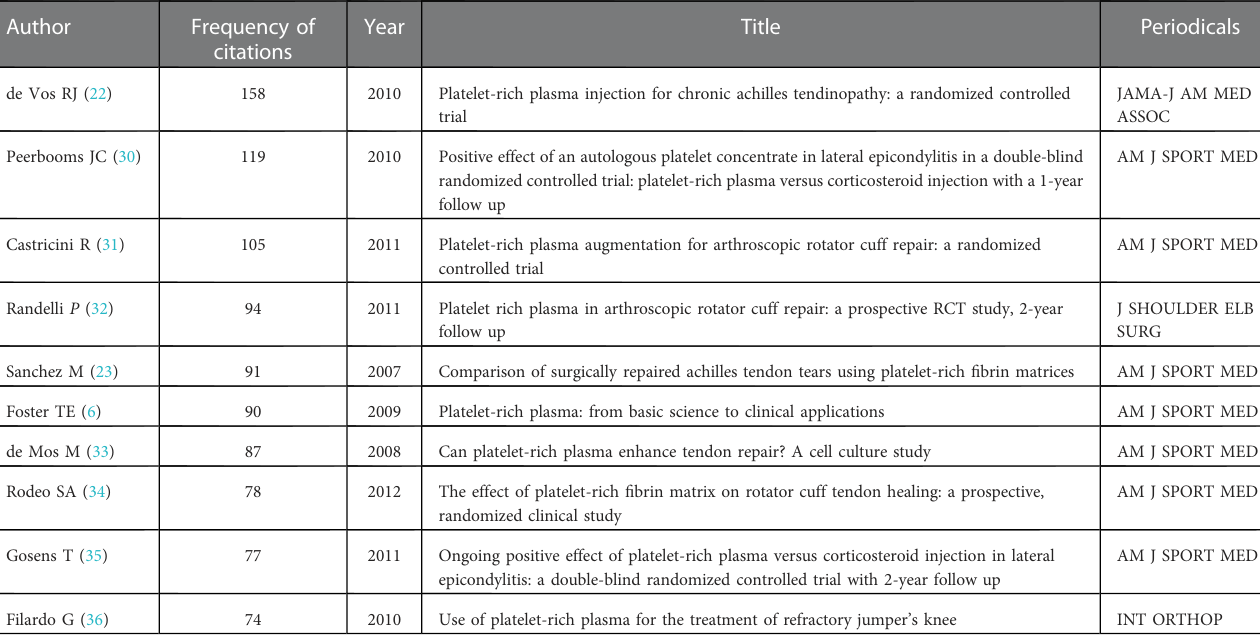
TABLE 6 Top 10 cited literature frequency ranking of using platelet-rich plasma to treat ligament and tendon injuries.